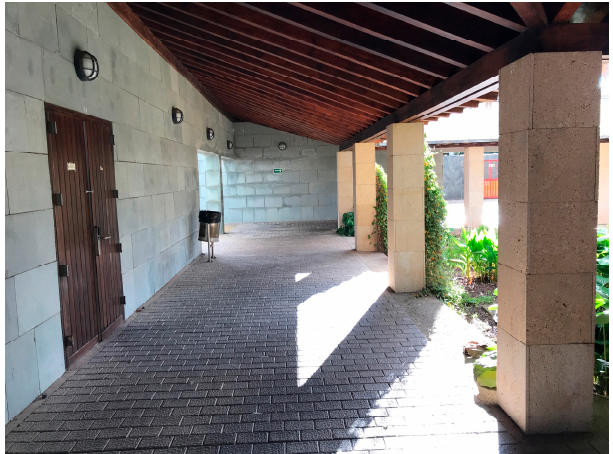
Figure 5. View of the first scenario where TB1 is located.